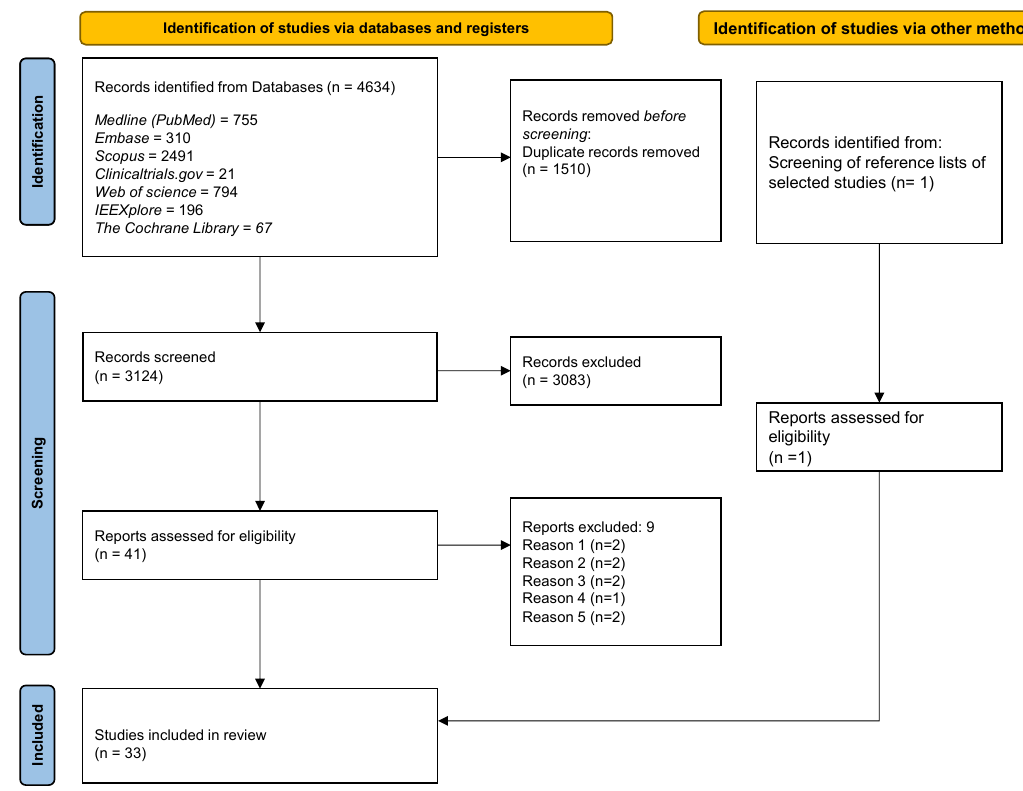
Figure 1. Flow diagram of the search and selection